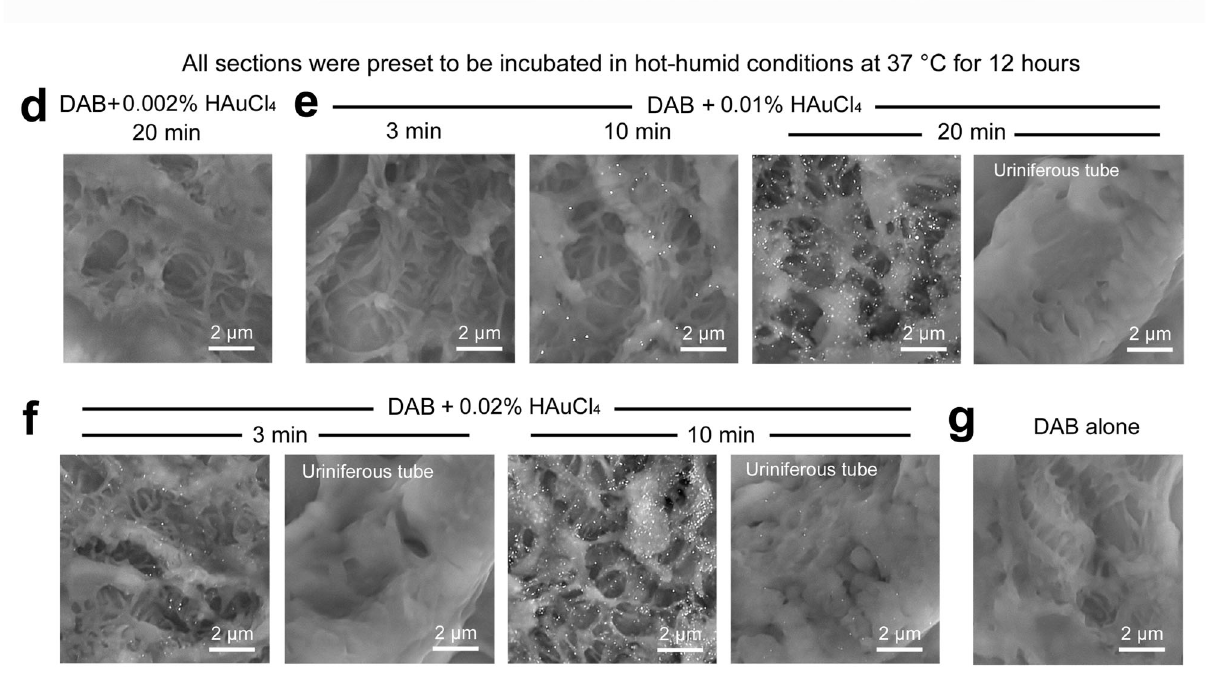
Fig. 2 Prototype of the in situ nanogold labeling and coordination of HAuCl 4 concentration and treatment time. a Contrast enhancement with 0.1% HAuCl 4 for the DAB deposition sites (arrowheads). Note the undifferentiated enhancement at the contours of the uriniferous tube and the blood vessel (v) caused by the edge effect under low-vacuum SEM. b Optical color change in the cell/tissue section after hot-humid incubation at 37 °C for 12 h. c Low- vacuum SEM images of the color-changed section. Note the intense nanogold labeling on the DAB deposition sites (in Box I) and nonspeci fi c particles over the uriniferous tube (in Box II). d – g All sections were preset to be incubated in hot-humid conditions at 37 °C for 12 h. d , e Nanogold labeling was insuf fi cient after treatment with 0.002% HAuCl 4 for 20 min ( d ) and 0.01% HAuCl 4 for 3 min compared with the standard treatment with 0.01% HAuCl 4 for 10 min ( e ). Intense labeling was obtained with 0.01% HAuCl 4 for 20 min, but it obscured the underlying fi ne structure of the podocyte process. f Appropriate labeling was obtained with 0.02% HAuCl 4 for 3 min, but the short elongation of 10 min caused nonspeci fi c particles on the uriniferous tube. g DAB alone as a negative